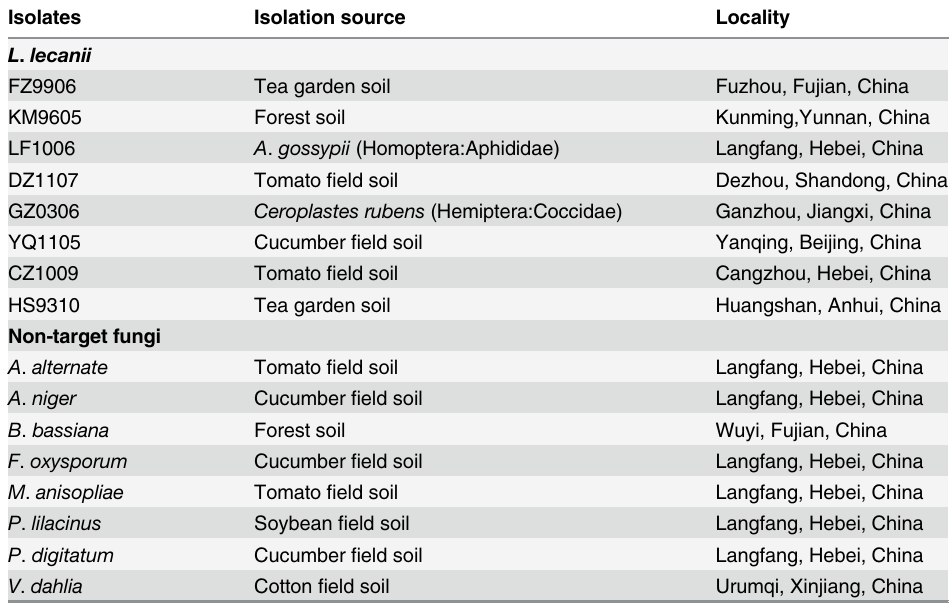
Table 1. Origin of fungal isolates used in tests to evaluate the effectiveness of